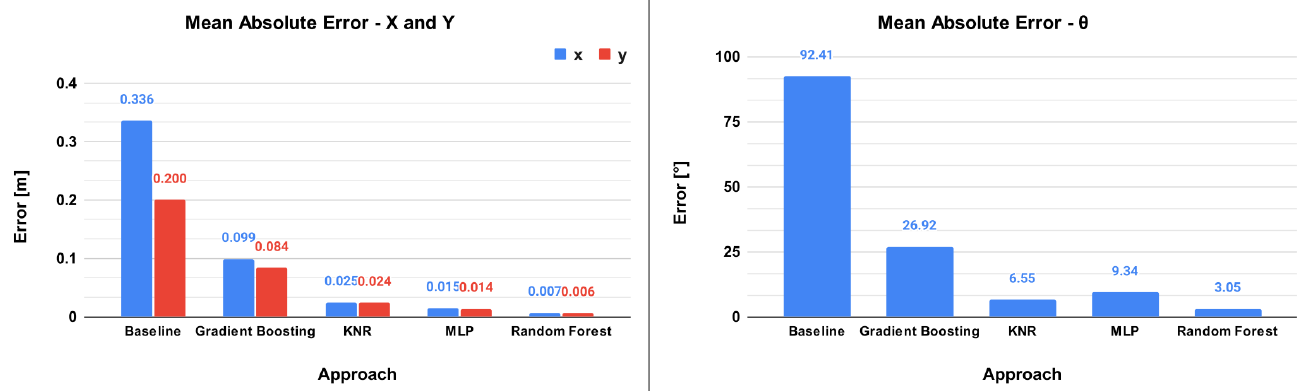
Figure 11. Image on the left displays the MAE for the x and y axes in meters and the image on the right displays the MAE for the θ in